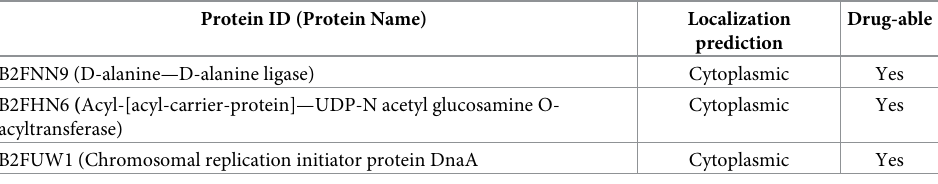
Table 2. Sub cellular localization prediction of proteins involved in unique metabolic pathways.